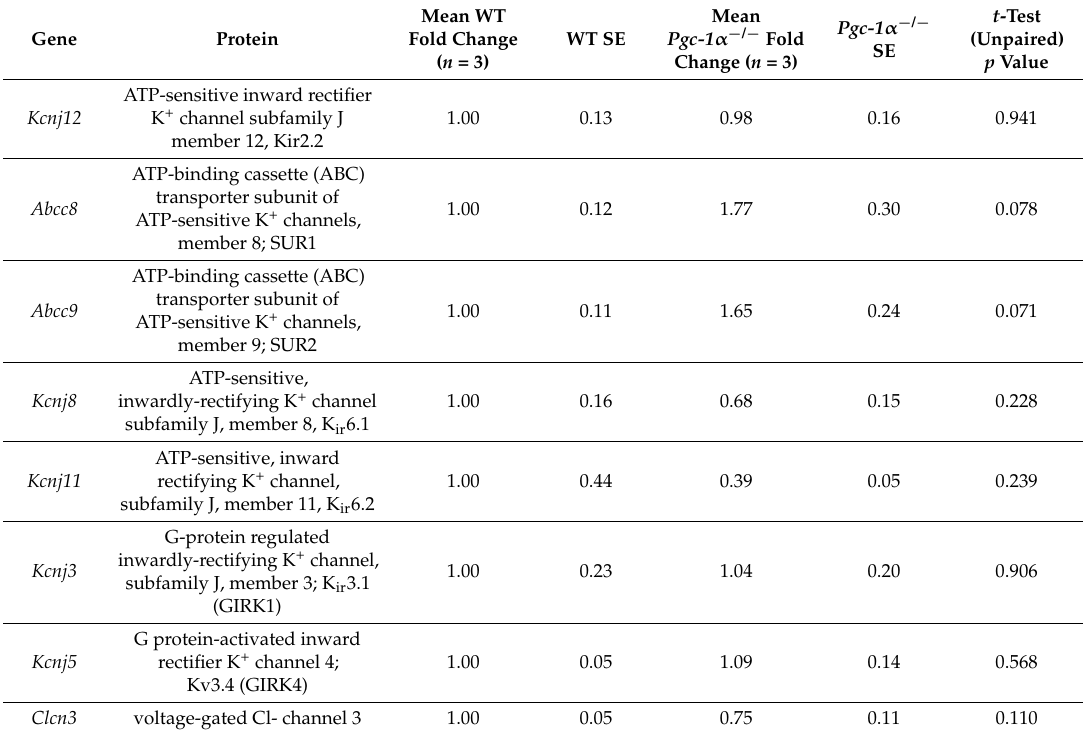
Table 2. The mean gene-fold changes underlying channels relating to the resting membrane potential in Pgc-1 α − / − compared to WT